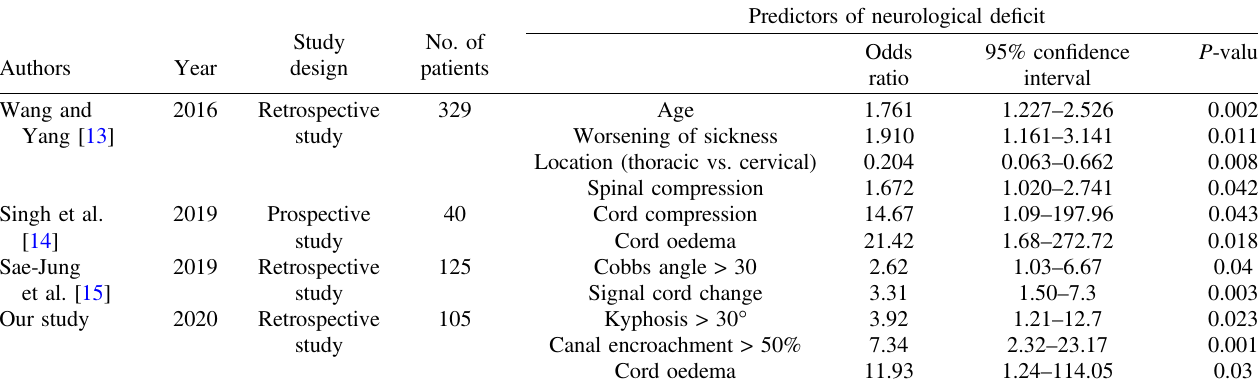
Table 4. Comparison of studies in literature predicting neurological de fi cit in TB